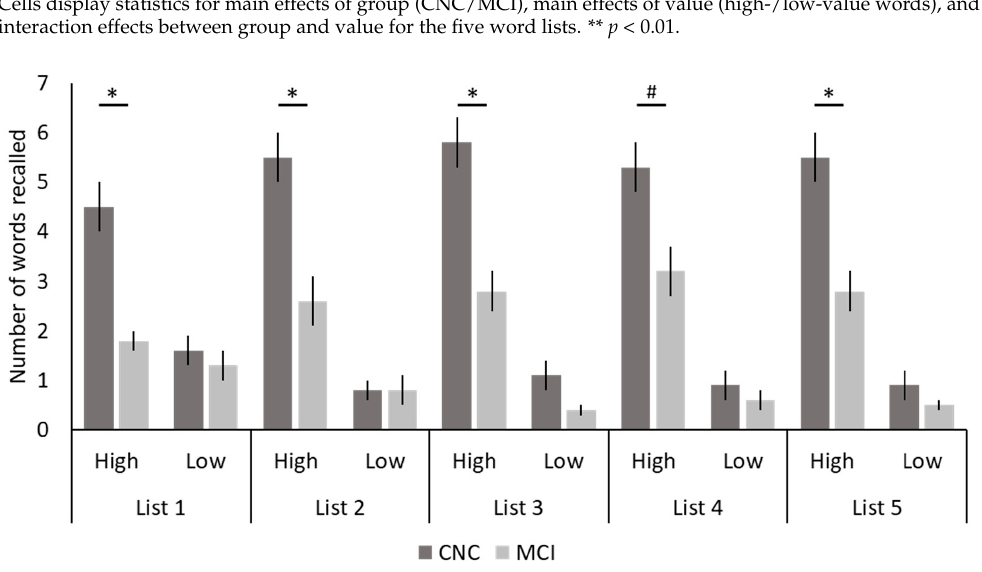
Table 2. Statistical Results for Task-Related Behavioral Data.